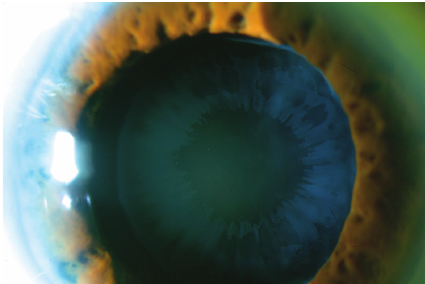
Figure 2: Pseudoexfoliative deposits on IOL in OS.